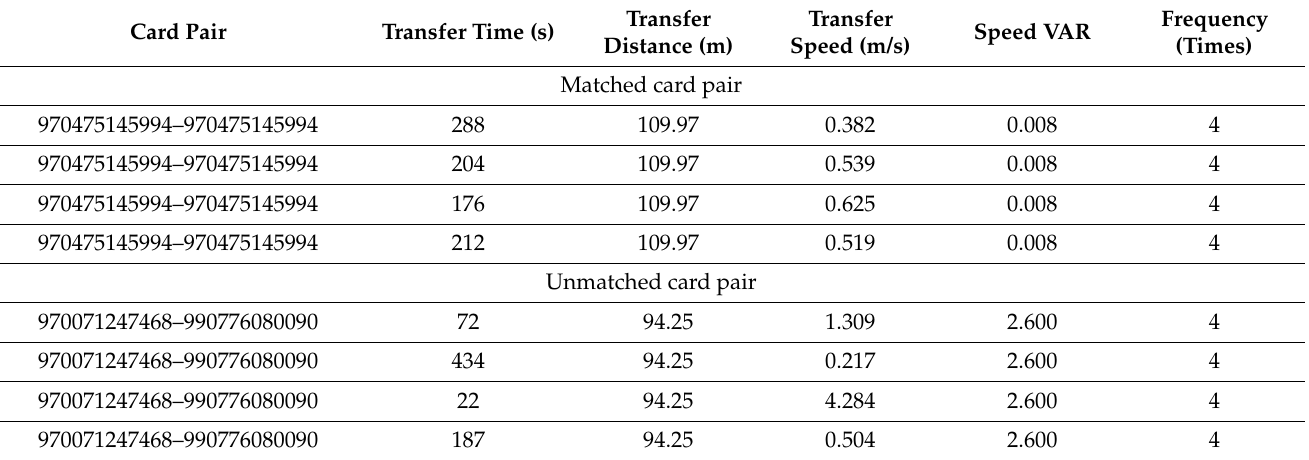
Table 1. The structure of the dataset used in the